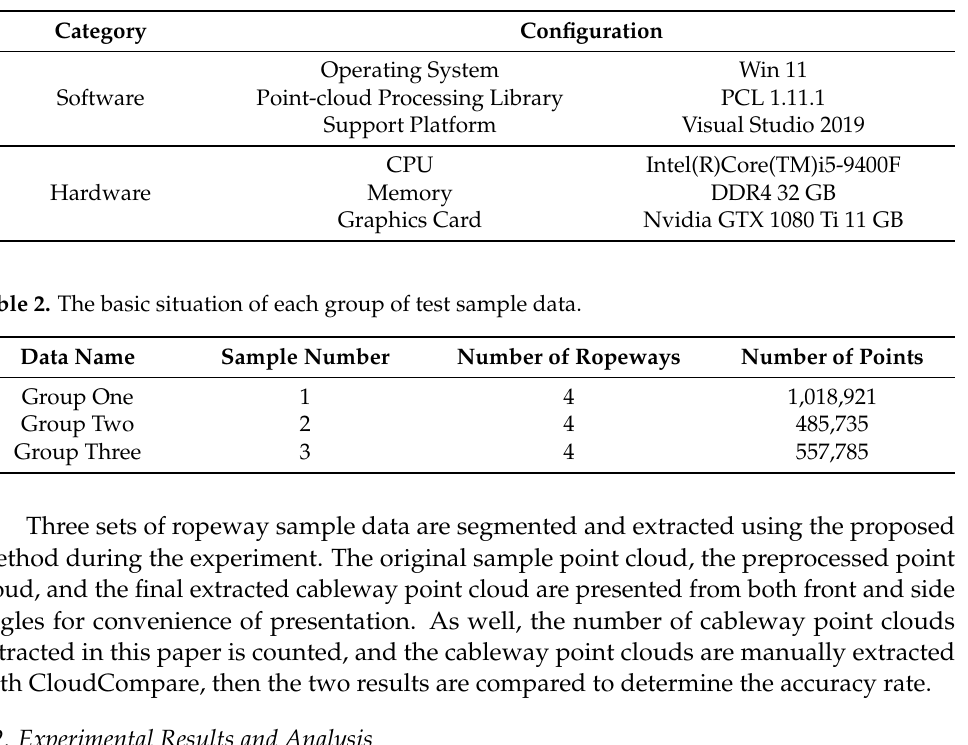
Table 1. Models and configuration parameters of software and hardware used in the test experiment.